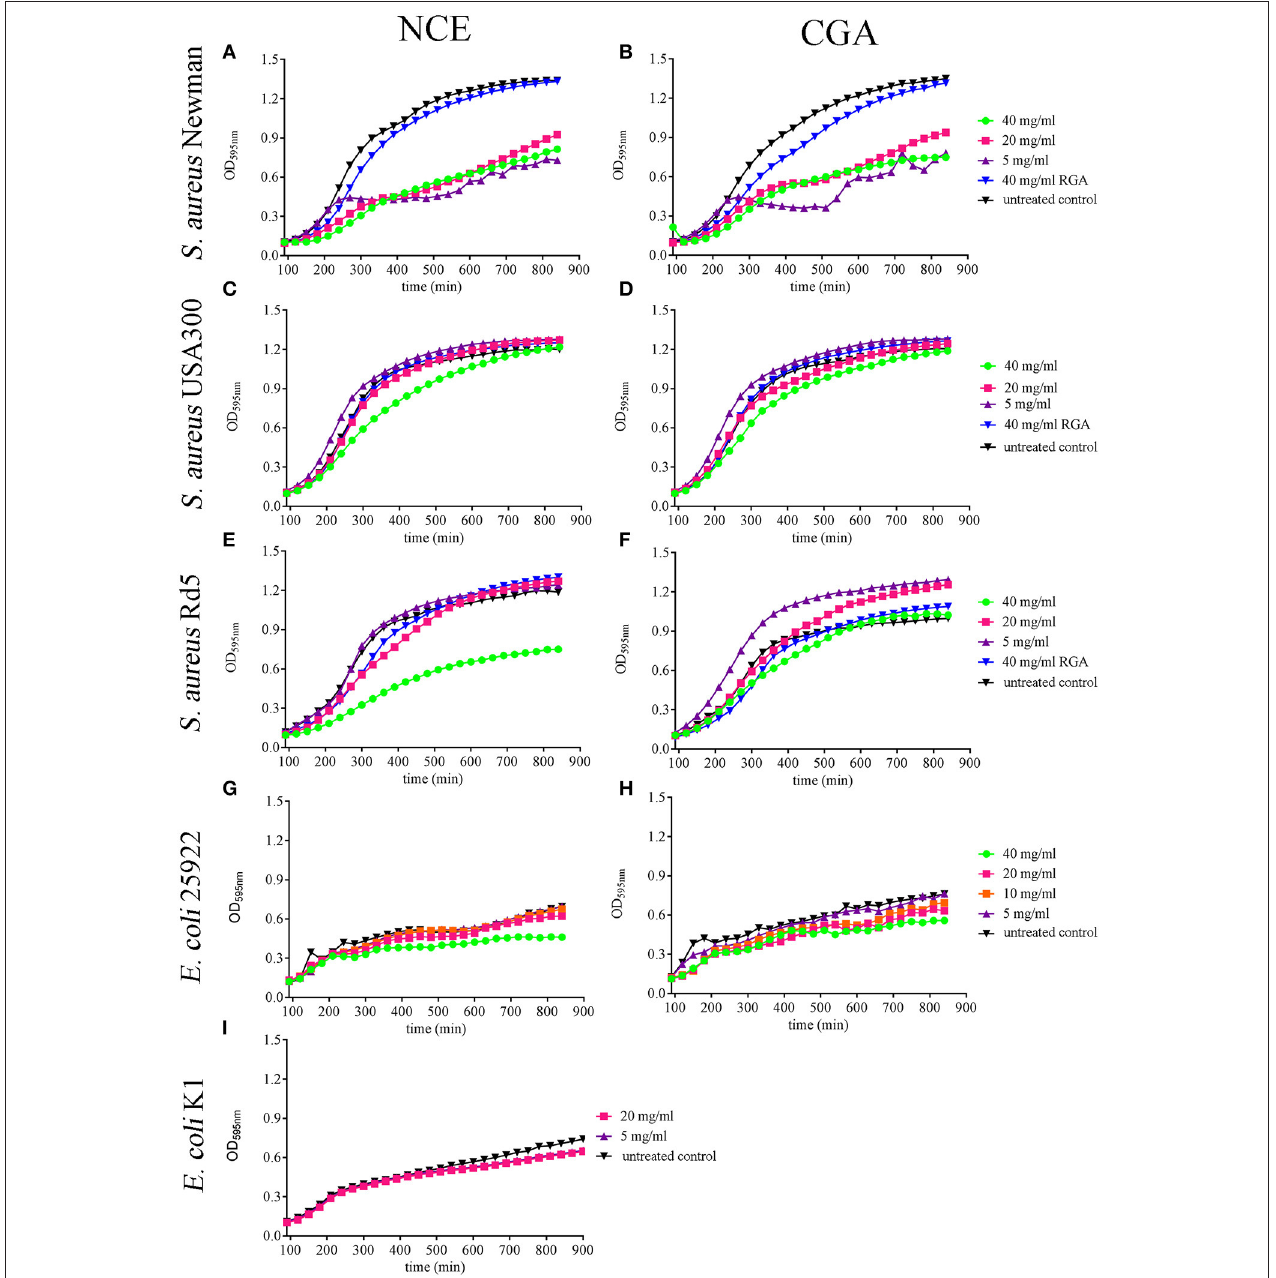
FIGURE 1 | Effect of natural crude extract (NCE), commercial GA (CGA), and artificial sugars (RGA) on growth of S. aureus strains and E. coli strains in MHB over 14h. The growth of different S. aureus and E. coli strains was analyzed in the presence of different GA concentrations by measuring the OD in a plate reader. (A,B) All tested concentrations of NCE (A) and CGA (B) significantly inhibited the growth of S. aureus Newman compared to the untreated control. The inhibition effect of 40mg/ml NCE started at 180min, 20mg/ml at 210min, and 5mg/ml at 240min. For 40mg/ml and 20mg/ml CGA, the growth-inhibiting effect started at 240min and for 5mg/ml at 300min. Rhamnose, galactose, and arabinose (RGA = artificial sugars) had no effect on S. aureus Newman growth ( n = 3). (C,D) Only 40mg/ml of NCE (C) and CGA (D) slightly inhibited after 210min the growth of S. aureus USA300 compared to the untreated control (NCE: n = 5 and CGA n = 6). This effect was lost over time. (E,F) Only 40mg/ml NCE (E) significantly inhibited the growth of S. aureus Rd5 after 210min, whereas CGA (F) had no effect ( n = 3). (G,H) 40mg/ml NCE and CGA significantly inhibited the growth of E. coli 25922. The effect started with NCE at 240min (G) and with CGA at 480min ( n = 3). (I) NCE had no effect on the growth of E. coli K1 ( n = 3). Statistical analysis was done by two-way ANOVA followed by Dunnett’s test compared to the untreated control. Each treatment was done in duplicate and a mean of duplicates was used for statistical analysis. The number of independent experiments is presented above. P ≤ 0.05 were considered